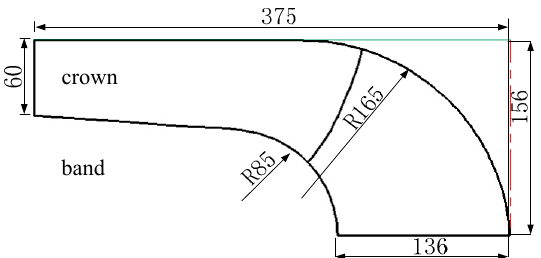
Figure 4. Meridian passage of the runner blade (unit: mm).